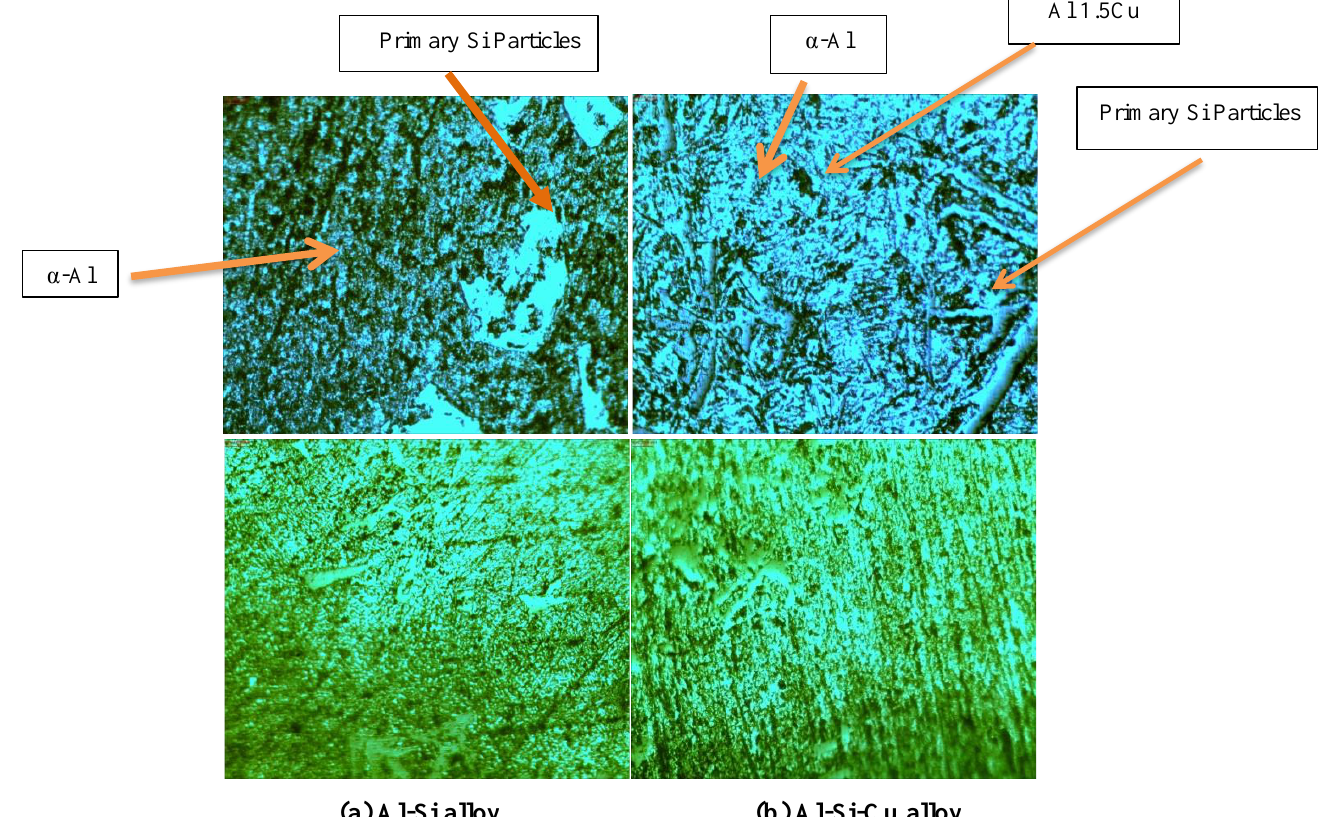
Figure 5: As received